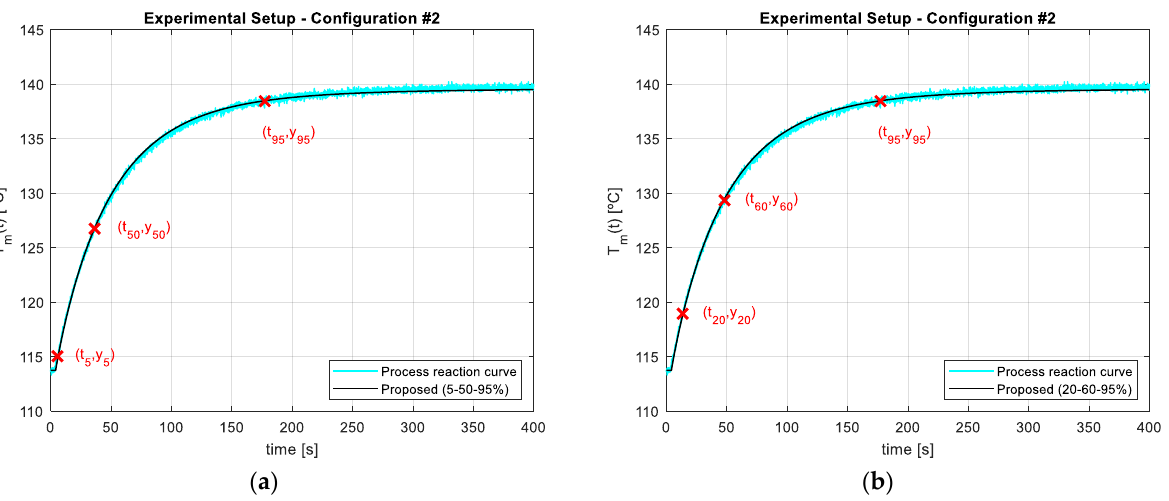
21 of 41 Table 9. Process information for Configuration #2 for fractional-order model identification with sets of points (5 – 50-95%) and (20-60-95%).